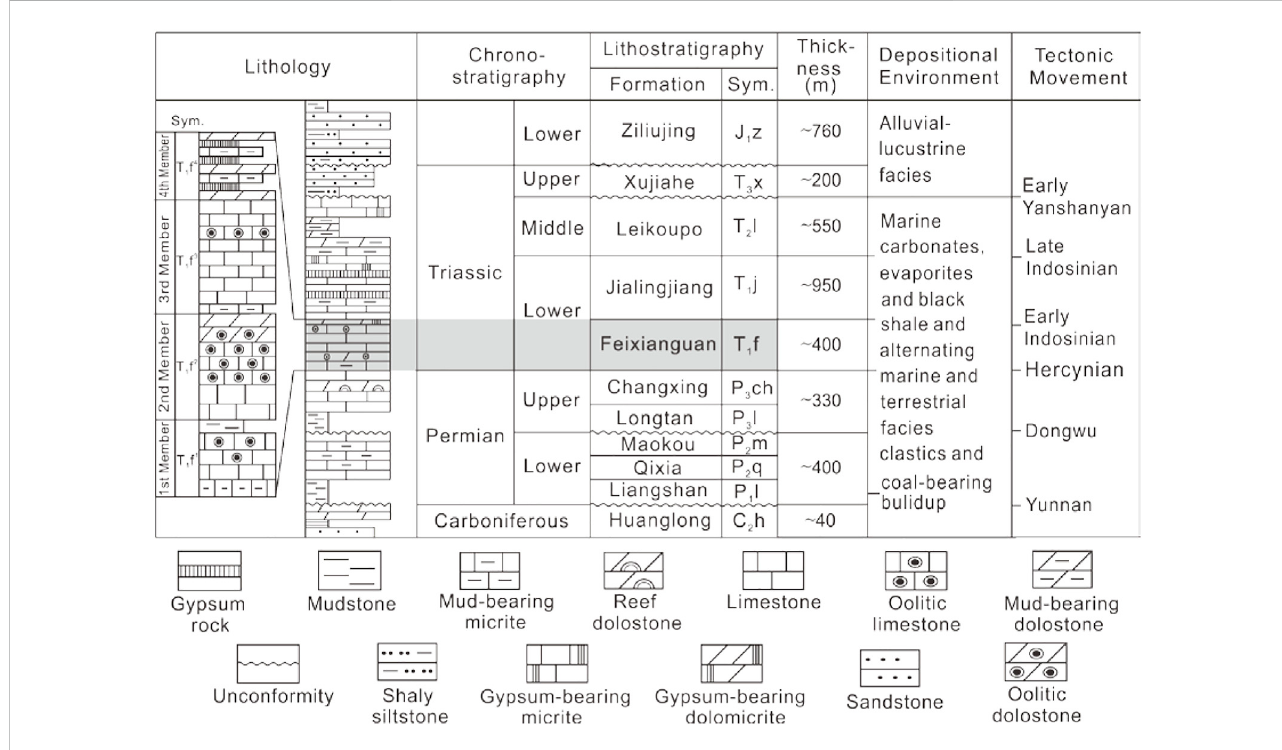
FIGURE 2 Generalized stratigraphy and tectonic history of the study area (modi fi ed from Hao et al., 2008). Sym, symbol.